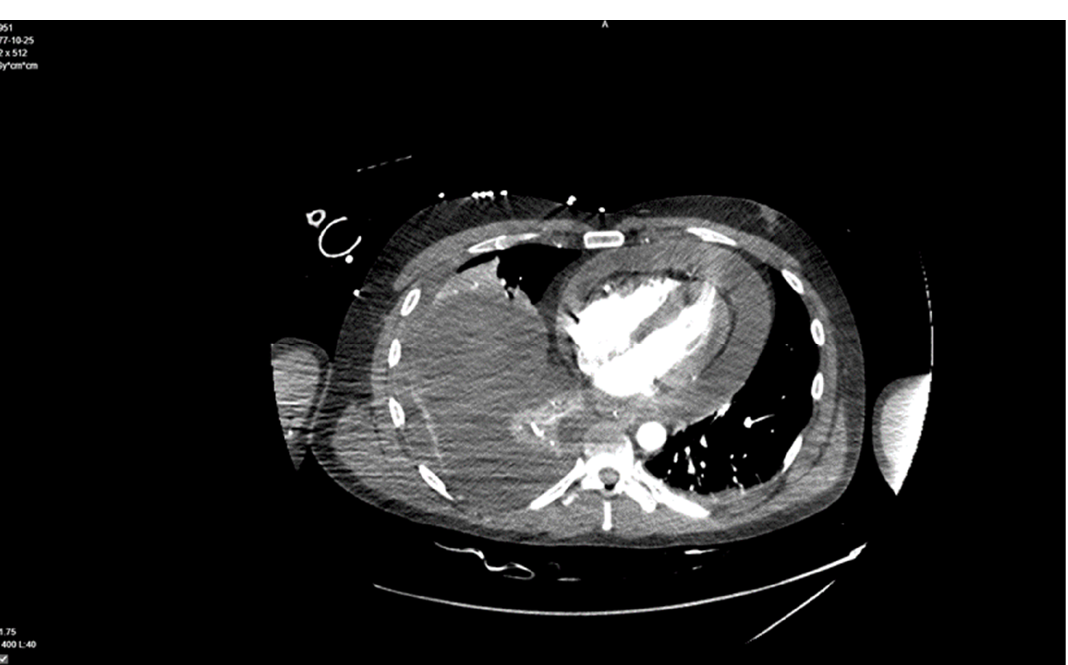
Figure 2. Transthoracic echocardiogram showing a large pericardial effusion (most prominent around the left ventricular posterior wall and the left ventricular apex with about 2.7 cm and 2.4 cm in diameter, respectively) with a ventricular systolic collapse and a ‘’swinging heart’’ view.